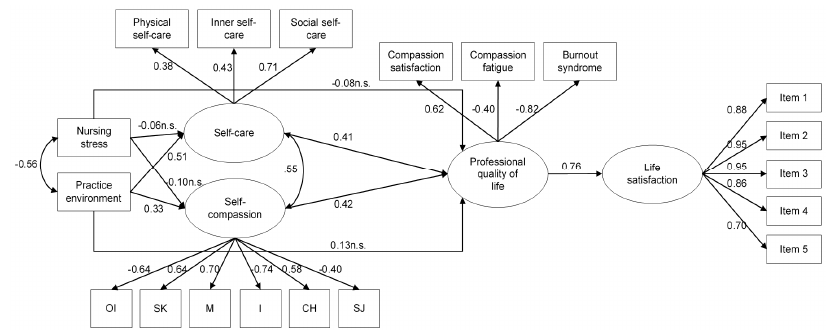
Figure 2. Estimated model. OI = over identification; SK = self-kindness; M = mindfulness; I = isolation; CH = common humanity; SJ = self-judgement. All the relations were statistically significant ( p < 0.01), except for the ones marked n.s. (non-significant).